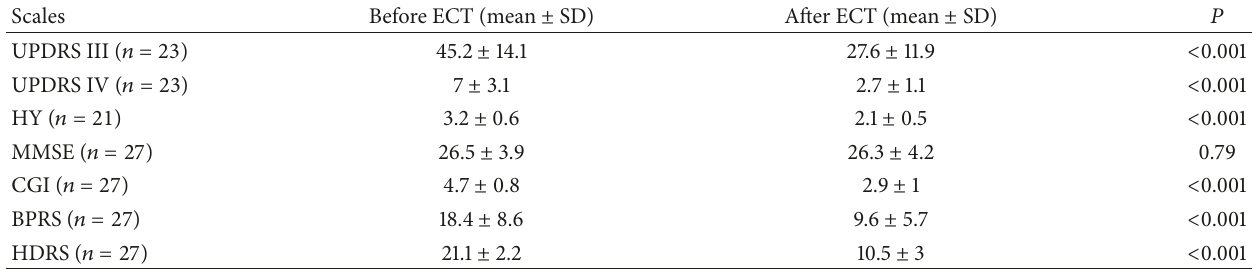
Table 7: Clinical evaluation with scales before and after the sessions of electroconvulsive therapy